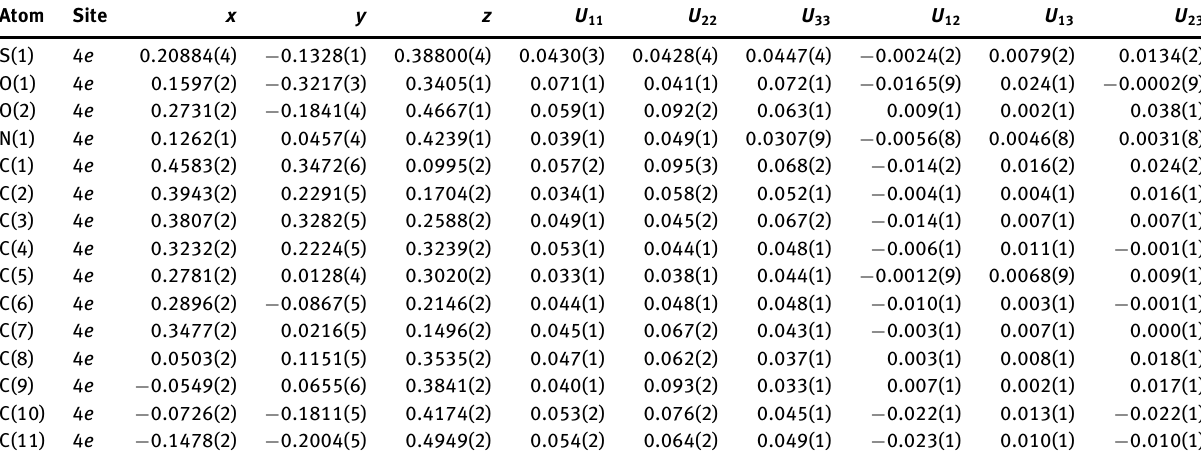
Table 3: Fractional coordinates and atomic displacement parameters (Å 2